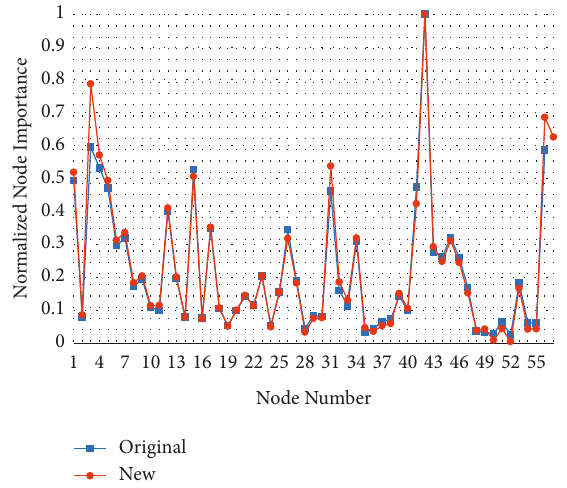
Figure 7: Comparison of normalized node importance before and after adding new node.